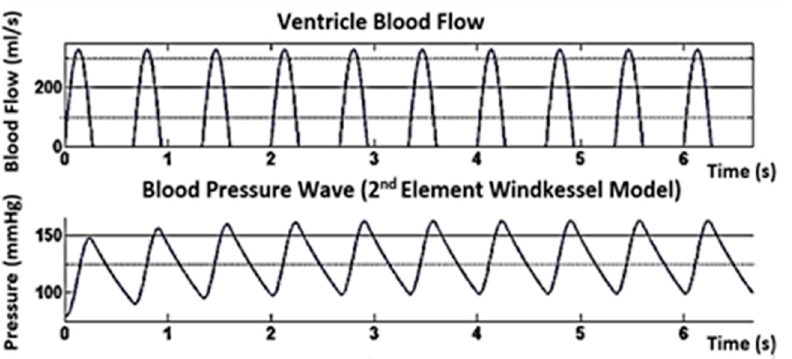
Figure 2. BP simulation using a two-element Windkessel model for SBP/DBP = 160/100 mmHg and HR = 90 bpm parametric models.